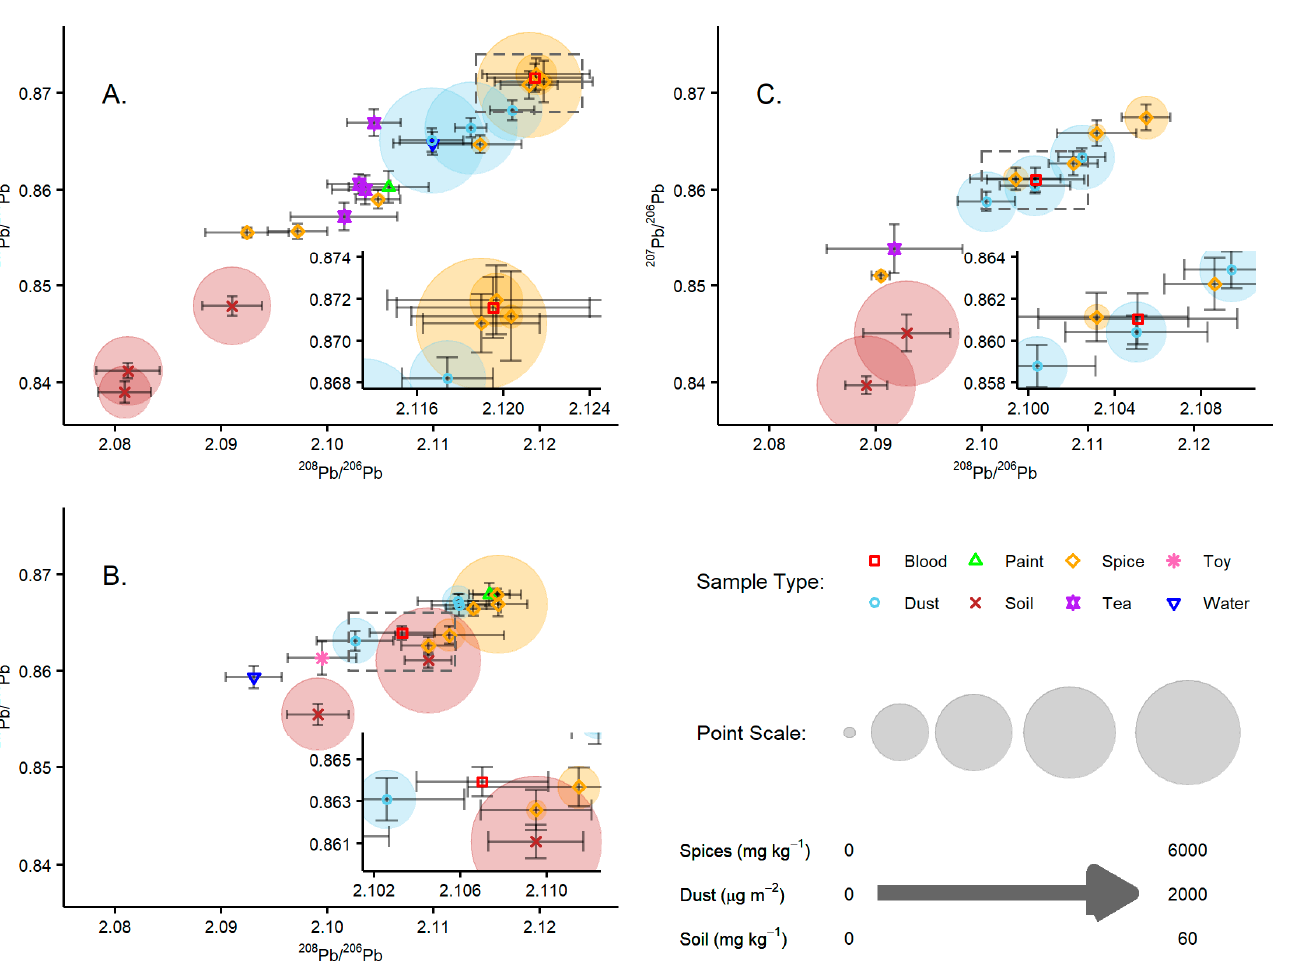
Figure 5. Lead isotope plots of the blood and environmental samples collected from each of the three households. Insets show a zoomed-in area of the plots focused around the corresponding blood data and are indicated by the rectangles outlined by a dashed line in the main plot. Scaled points are also included for the spice, dust, and soil samples to give an indication of the total Pb concentration for the corresponding sample. ( A )—Isotope ratio data from Household A. ( B )—Isotope ratio data from Household B. ( C )—Isotope ratio data from Household C.